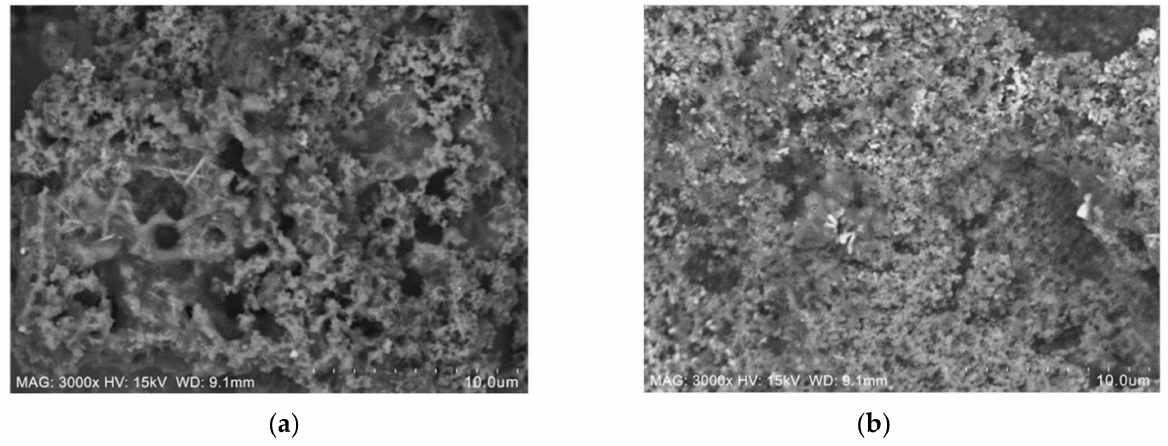
Figure 9. Coating surface sample after the fire resistance test: ( a ) S26 and ( b )